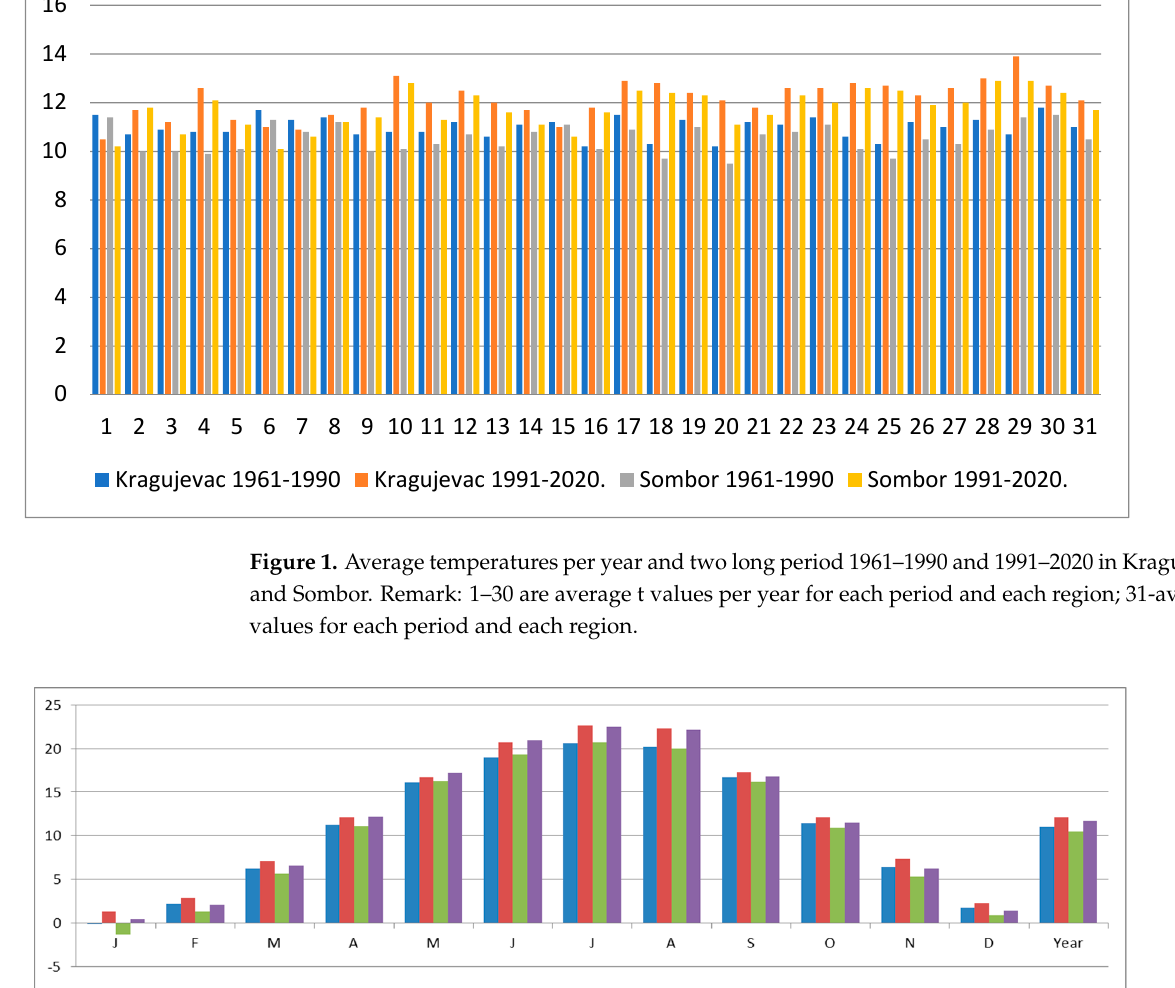
Figure 1. Average temperatures per year and two long period 1961–1990 and 1991–2020 in Kragu- jevac and Sombor. Remark: 1–30 are average t values per year for each period and each region; 31- average values for each period and each region.